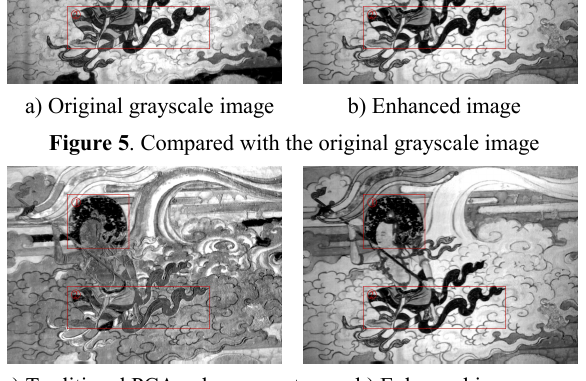
Figure 6 . Comparison of linear feature enhancement